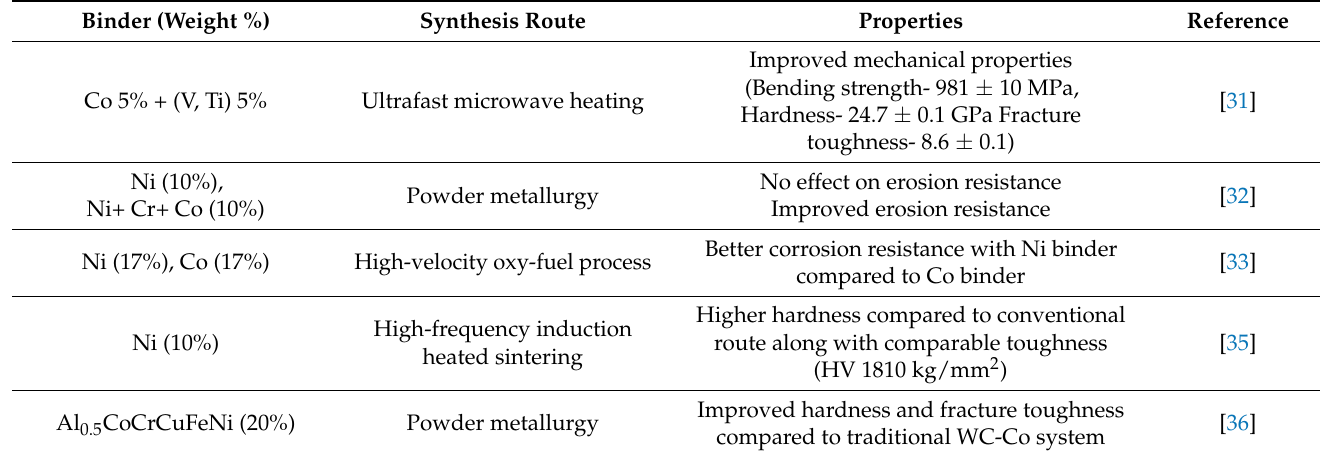
Table 1. Effect of binder composition and synthesis on the properties of WC-based cermets. Binder (Weight